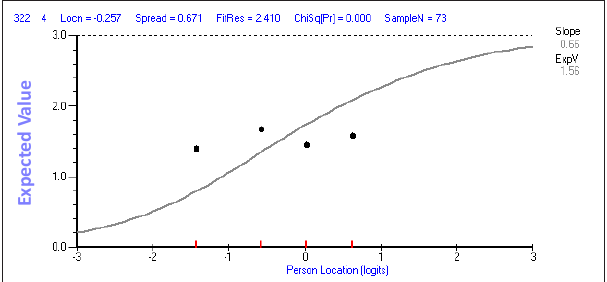
FIGURE 3: Item characteristic curve for Item 3.2.2, indicating under-discrimination.